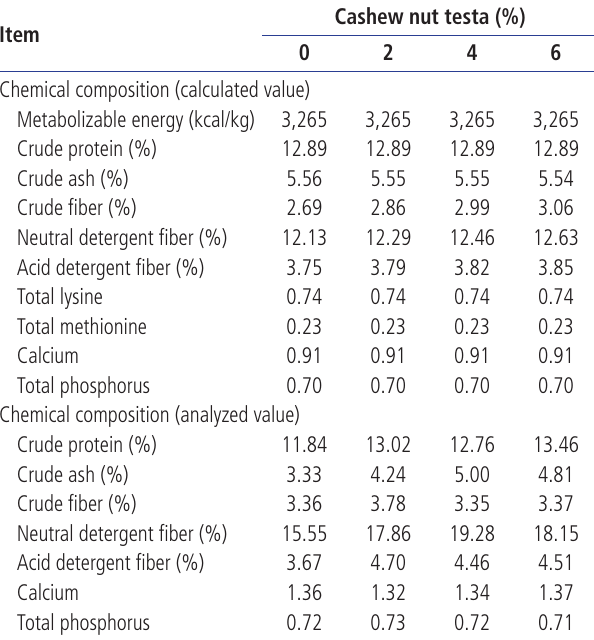
Cashew nut testa